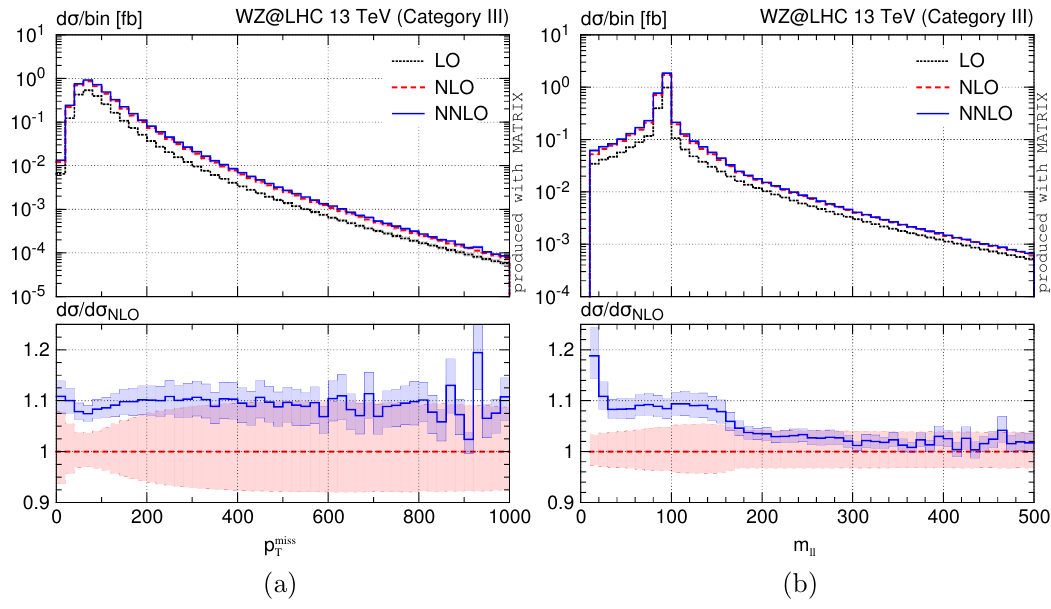
Figure 16 . Distributions with respect to (a) p miss additional m T;W > 120 GeV cut (Category